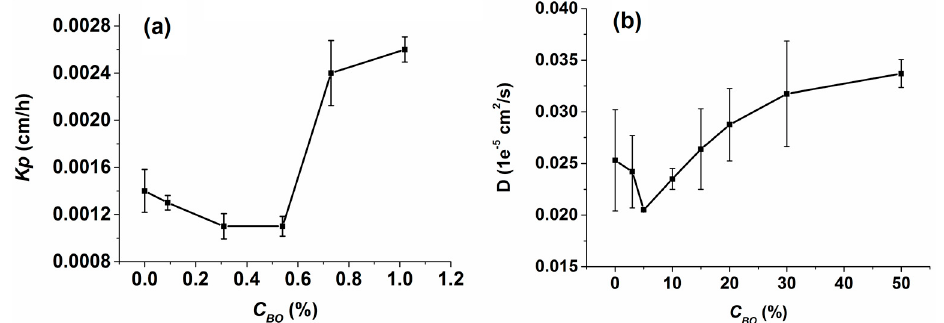
Figure 9. ( a ) Permeability coefficient K p of osthole obtained from in vitro experiments; and ( b ) diffusion coefficient D of osthole obtained from CG-MD simulations. Either K p or D reflects the diffusion rate of osthole in the corresponding lipid bilayer systems.